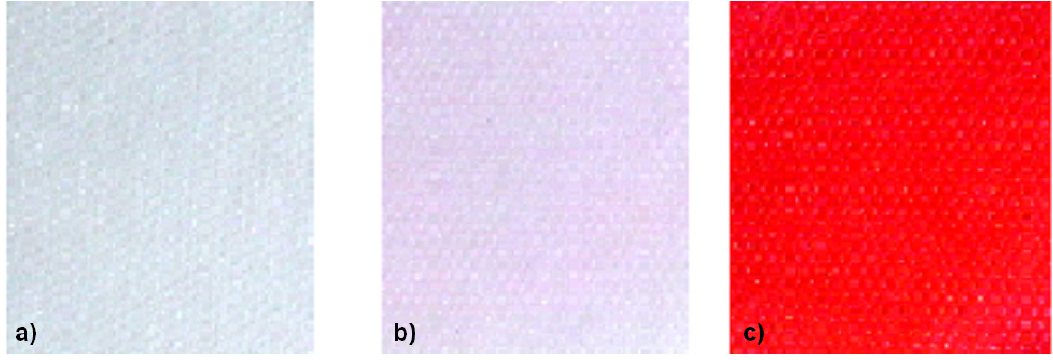
Figure 8: Surface dyeing of polypropylene nonwoven using water solution of acid red a) PPNW, b) PPNW dyed after plasma activation, c) chitosan coated PPNW and dyed.